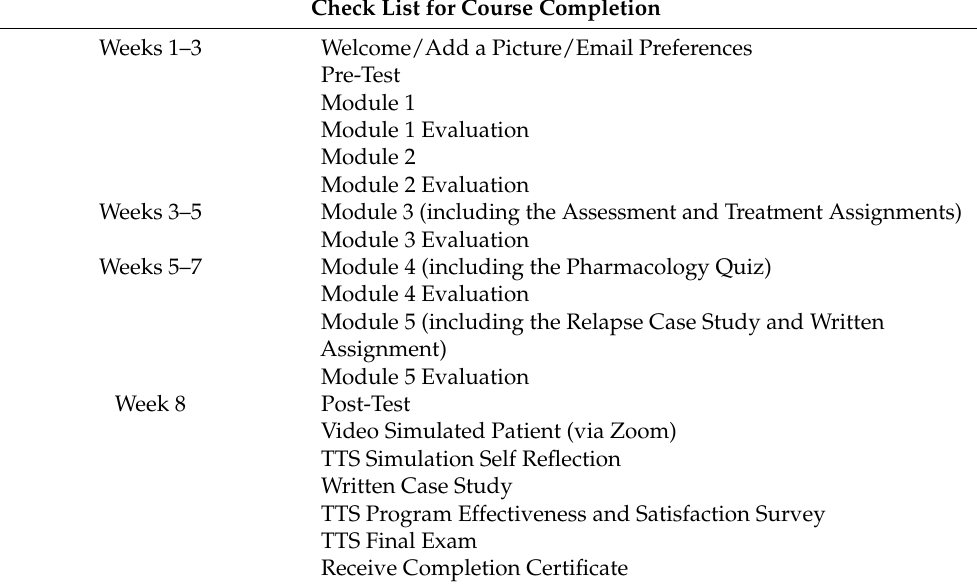
Table 1. Check list for course